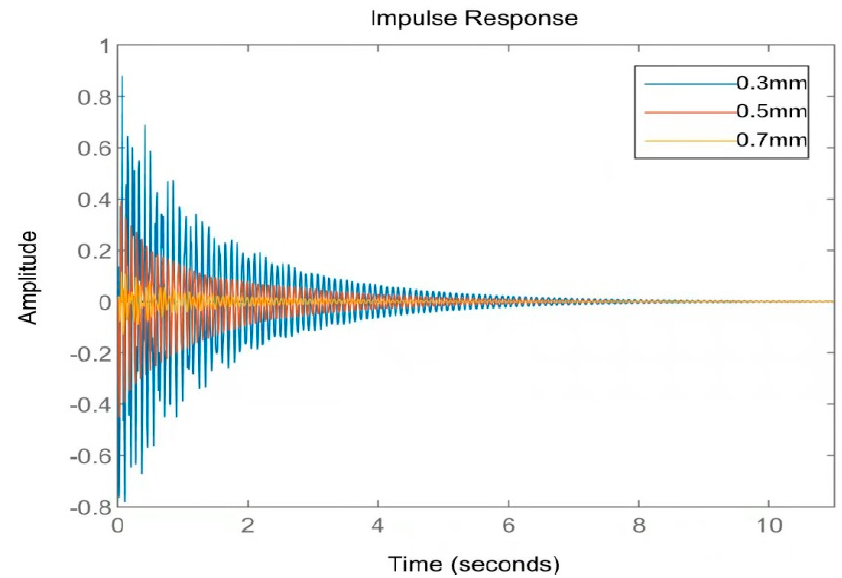
Figure 17. System response (no voltage applied) when piezoelectric sheets are of different thick-